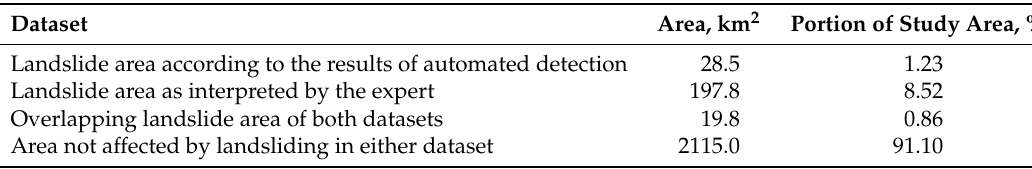
Table 1. Landslide area documented in the two landslide datasets.